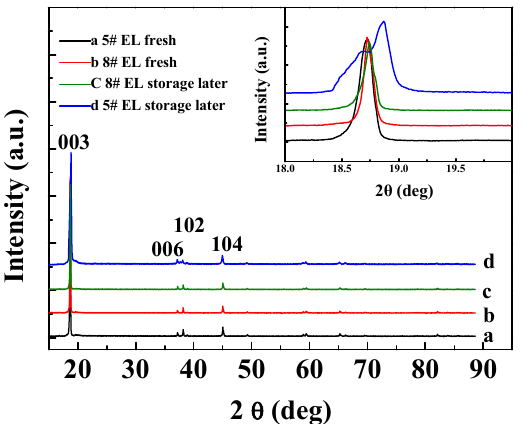
Figure 9. XRD characterization of the positive electrodes before and after high-temperature storage in different electrolyte groups (the inset illustrates the narrow scan of 003).